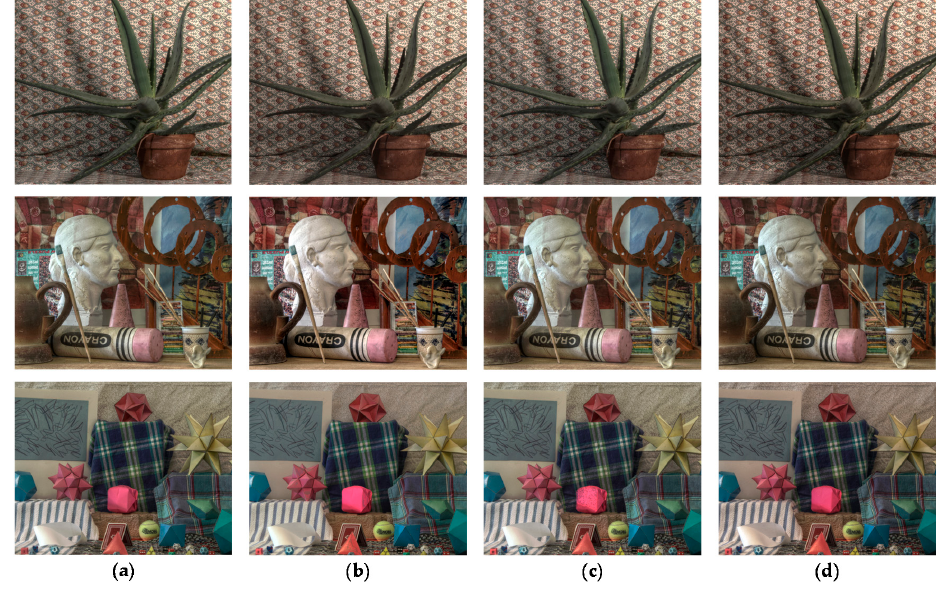
Figure 15. Resultant LDR images for the Middlebury database with normal-long exposure: ( a ) reference image; ( b ) Lin and coworkers’ method [14]; ( c ) Batz and coworkers’ method [16]; and ( d ) proposed method. Table 1. Quantitative performance evaluation from the HDR-VDP-2 quality score